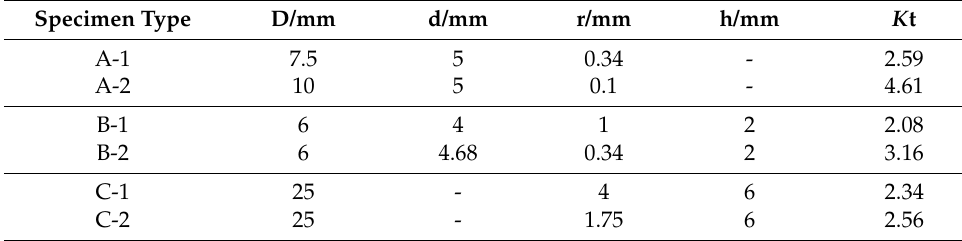
Table 1. Notched specimen size parameters.